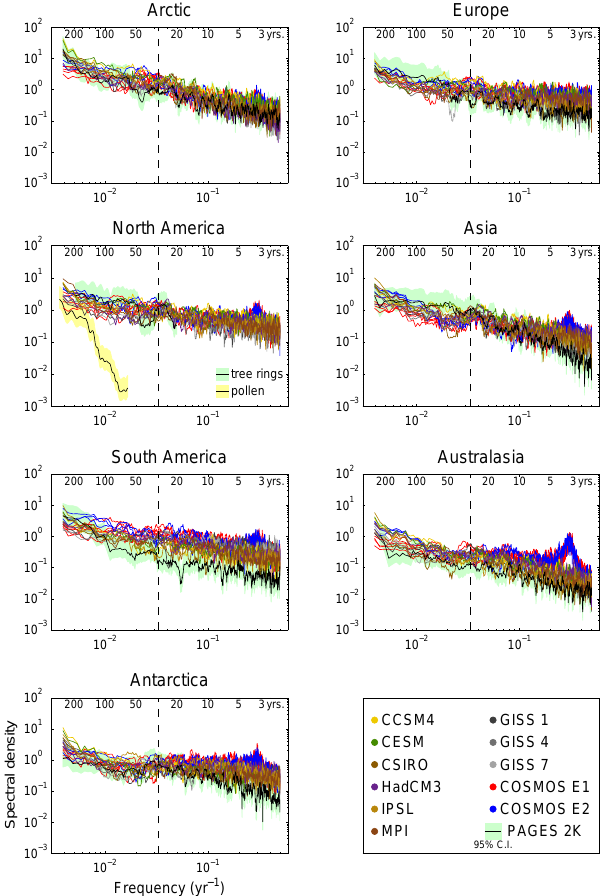
Figure 2. Spectral densities for simulations and reconstructions for PAGES 2k regions, calculated using all existing data in the pe- riod 850–2005 CE. Reconstruction spectra are illustrated with their 95% confidence intervals in coloured bands, while model spectra are shown with single coloured lines. Dashed vertical lines denote the limit for frequencies and periods of relevance (to the left of the line) for analyses made at the 15-year resolution, or with a 23-point Hamming window, as in many other analyses in this study. The multi-taper method (Thomson, 1982; Percival and Walden, 1993) was used, with the time–bandwidth product set to 4 and with long- term averages subtracted before estimating the spectra. Units are temperature variance ( ◦ C 2 or K 2 ) per frequency (year − 1